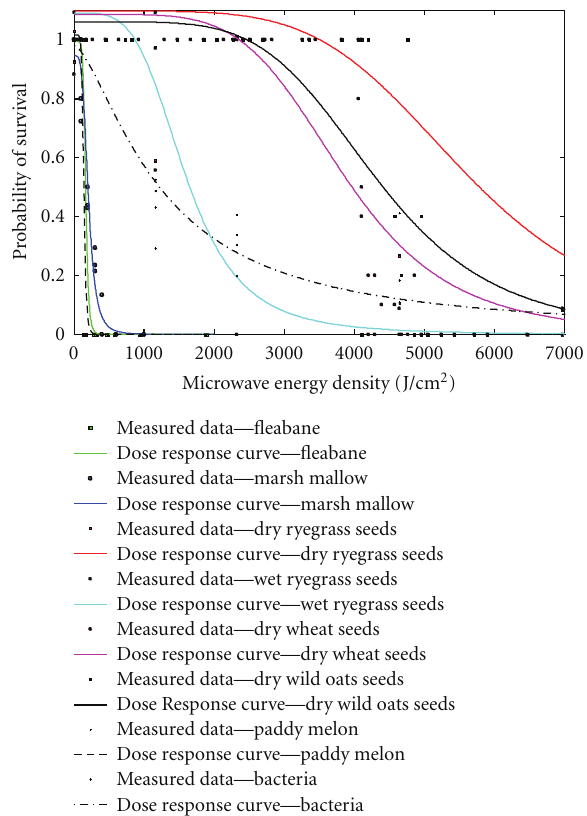
Figure 18: Microwave energy dose response curves for seeds (dry and moist), plants, and